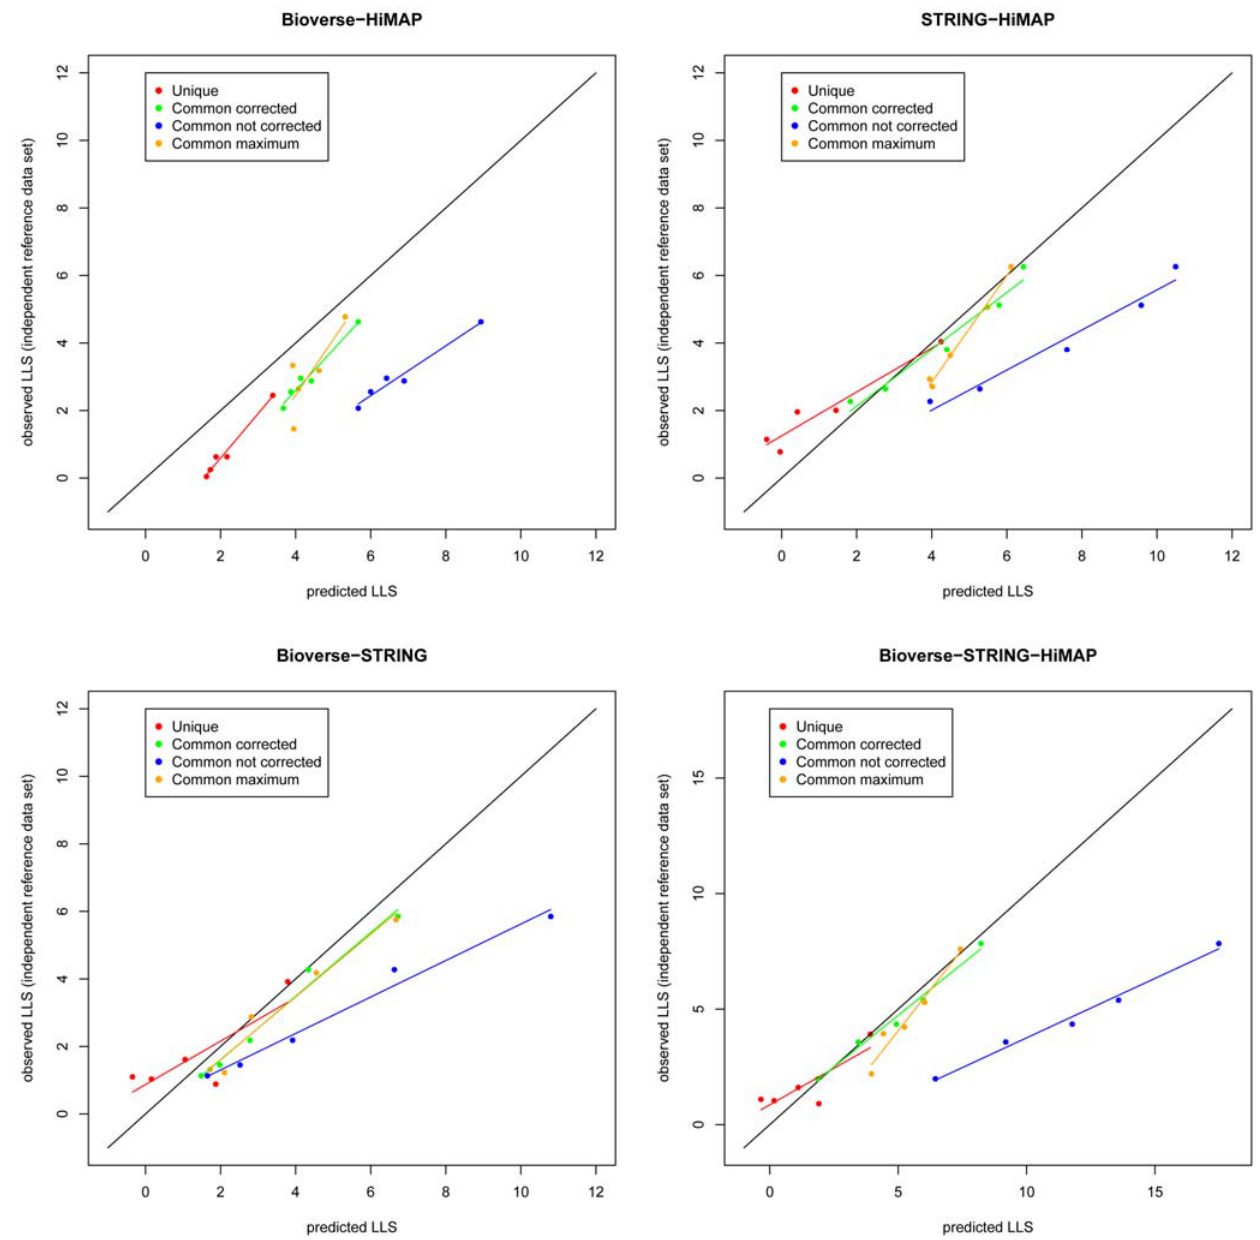
Figure 5. Assessing the linear bias correction. Linear regression plots for trained (predicted) versus tested LLS based on a second, independent reference data set for the different combinations of redundant subsets. Red line: interactions reported in only one database. Green and blue line: corrected and uncorrected LLS for interactions reported in at least two databases. Orange line: Using the maximum of the individual LLS instead of the sum. Ideally, all predictions should be along the diagonal. The bias corrected scores are clearly better predictors of the true interaction likelihood.